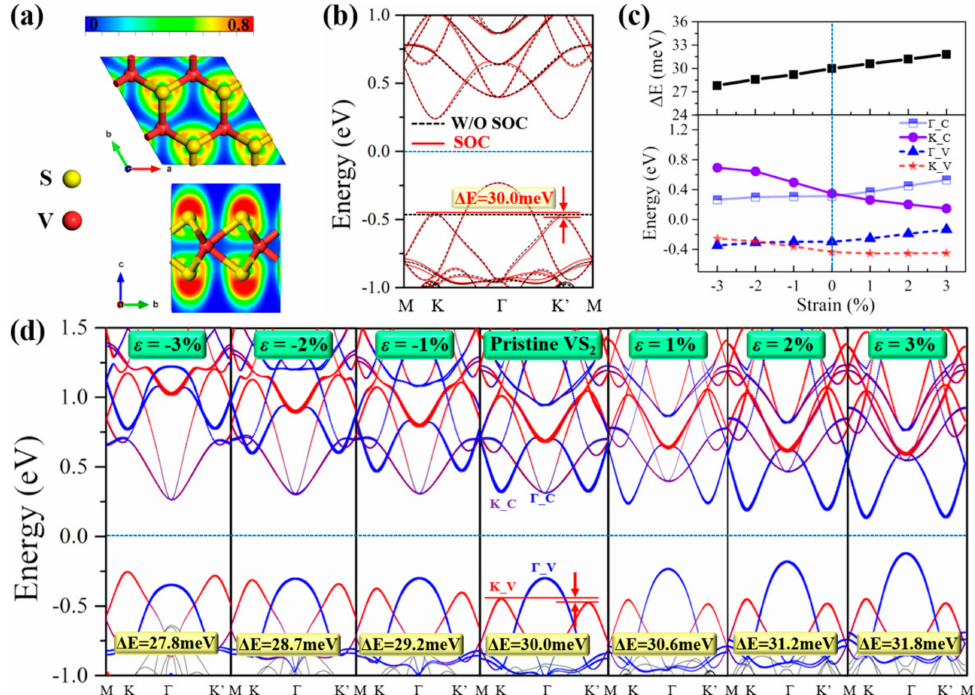
Figure 1. Valley splitting and band structures of pristine 2H–VS 2 . ( a ) Electron Localization Function (ELF) map of pristine 2H–VS 2 with top and front views of the optimized 2H–VS 2 ; ( b ) band structures without SOC (black dashed curves) and with SOC (red solid curves) of pristine 2H–VS 2 ; ( c ) valley splitting energies ( ∆ E) (upper panel) and conduction/valence band energies at K and G positions (lower panel) of VS 2 under biaxial strains; ( d ) valley splitting and band structures with SOC of VS 2 under biaxial strains. The red and blue lines denote the contributions from V– d xy + d x 2 − y 2 and V– d z 2 orbitals, respectively. The Fermi level is set to zero.